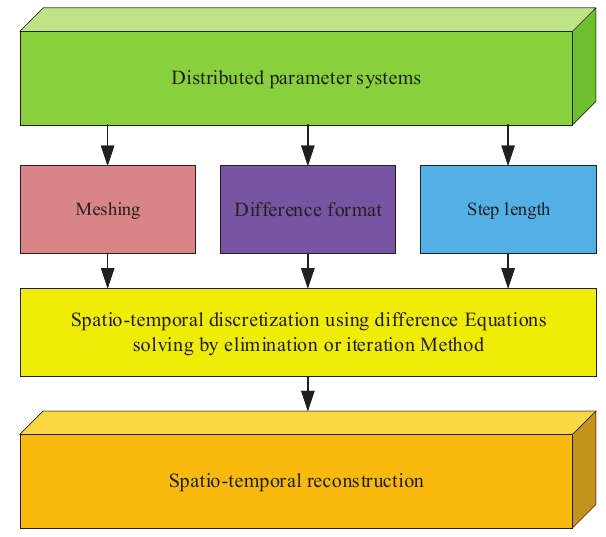
Figure 1. The finite difference